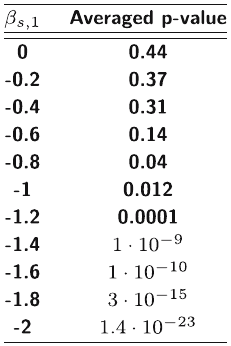
Figure 6: Empirical link between the logistic regression coe ffi cient for sampling bias β average p - value is computed by repeating 50 times the simulation. We recall that in Figure 4, β −0.4